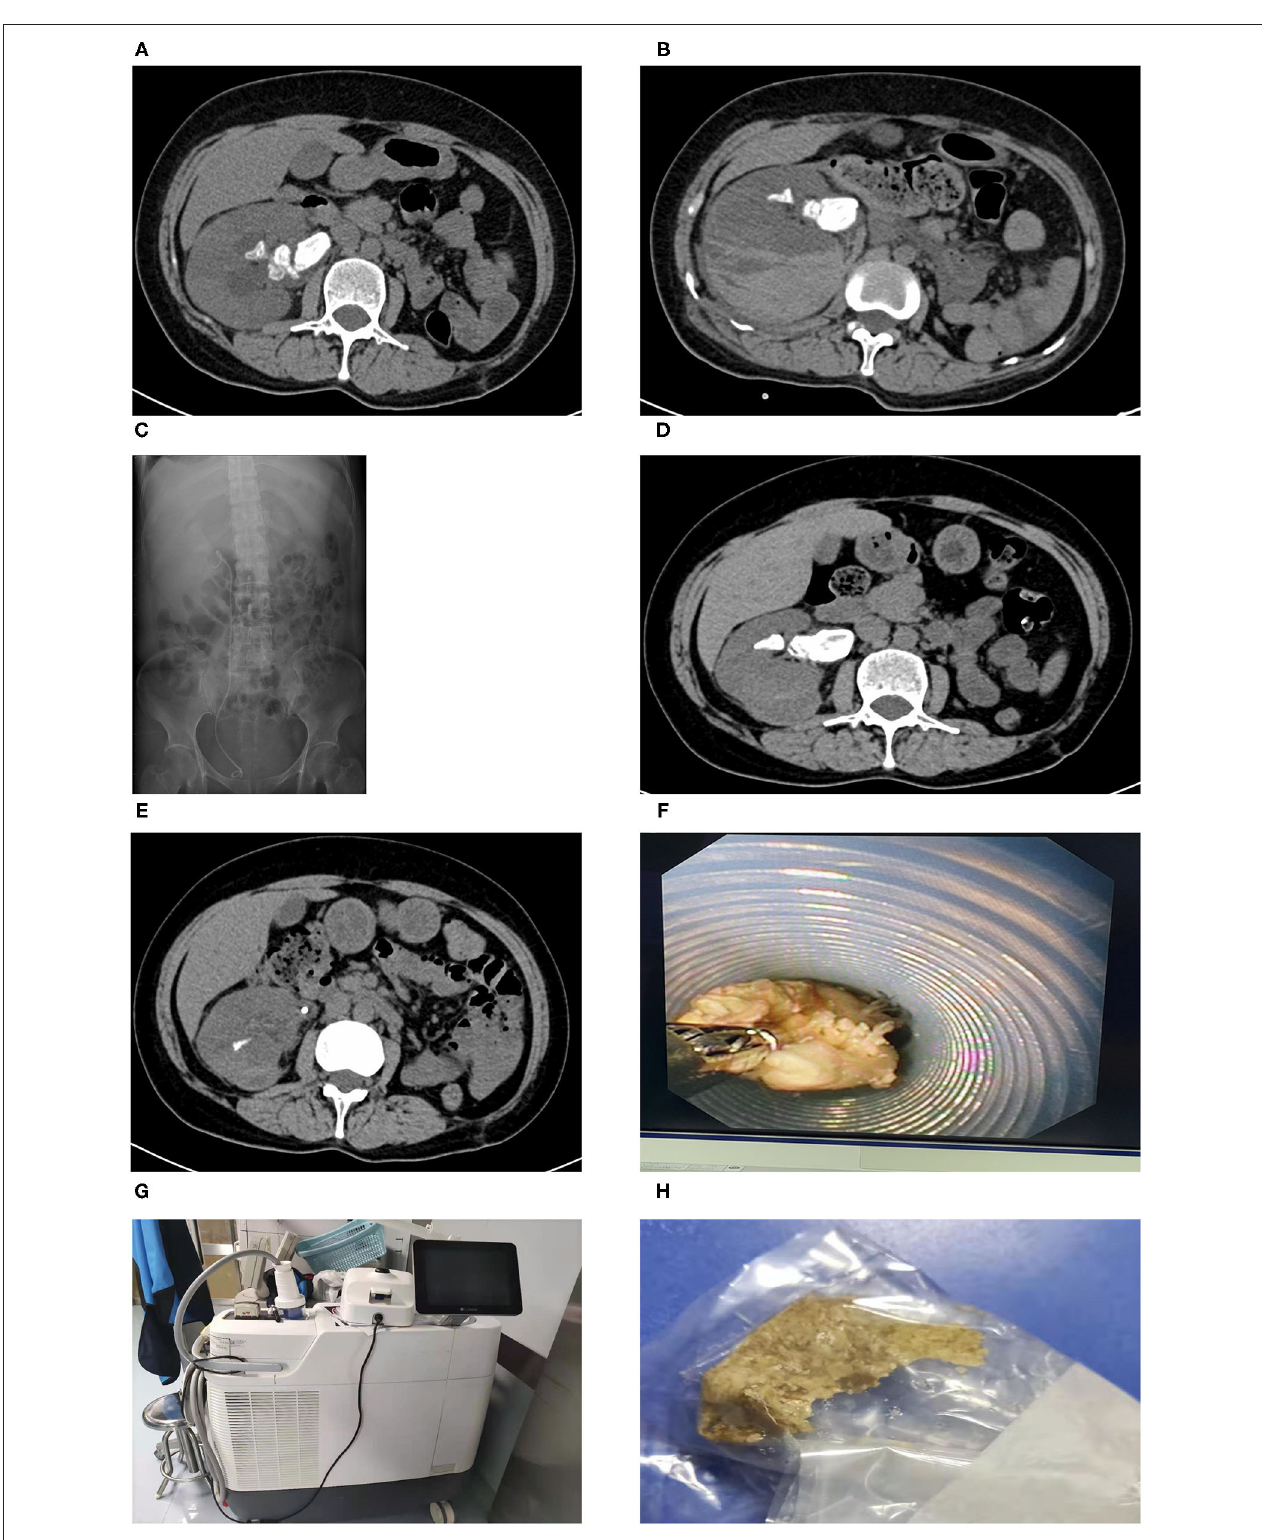
FIGURE 1 | The CT images throughout the period: (A) The abdominal CT at admission showing increased right kidney and staghorn stones among which the larger stone was about 3.0 × 1.8cm; (B) the abdominal CT after PCNL of right renal stones, which was terminated due to severe bleeding during channel establishment; (C) the abdominal KUB film after right ureteral stent placement; (D) the abdominal CT at readmission; (E) the postoperative abdominal CT of the third flexible ureteroscopy; (F) the image of flexible ureteroscopy forceps grabbing floppy stone; (G) Lumenis Pulse 120H; (H) infectious stones after the third procedure. PCNL, percutaneous